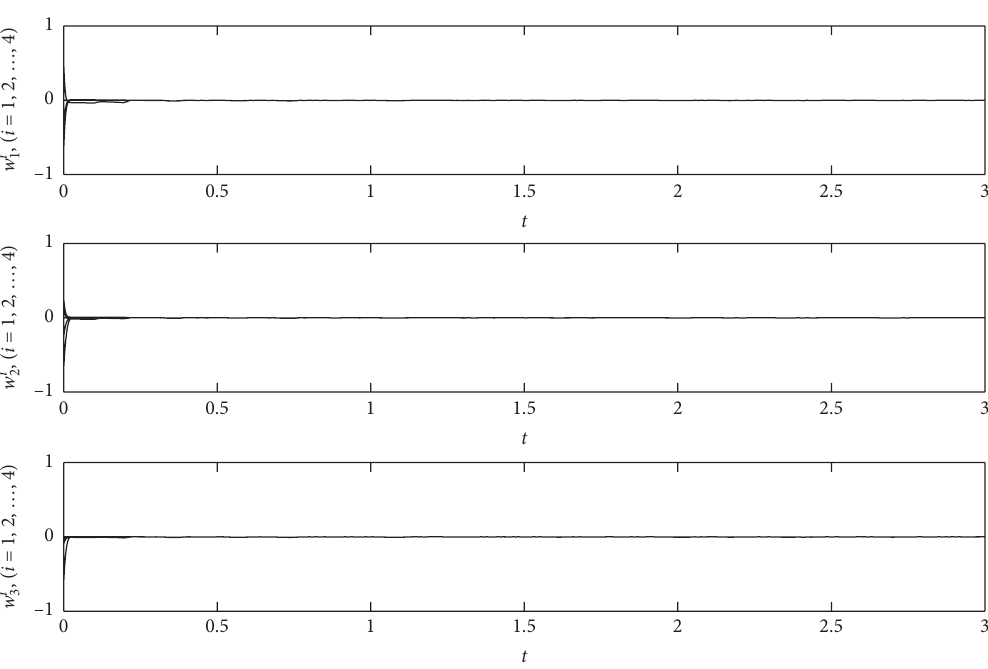
Figure 2: Synchronization evolution of two